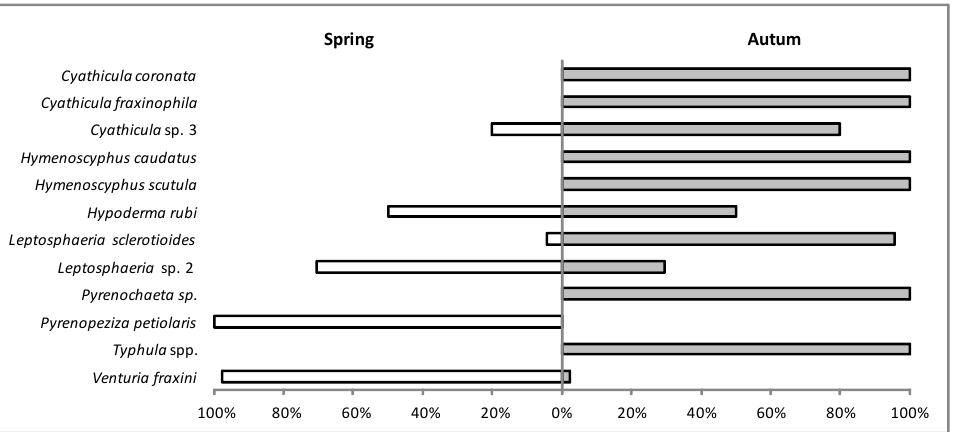
100% Figure 7. Fruit bodies of fungi (with frequency >2%) from the previous year’s leaf petioles of F. excelsior according to season. In spring, Typhula spp. produced only sclerotia with no sporophores.